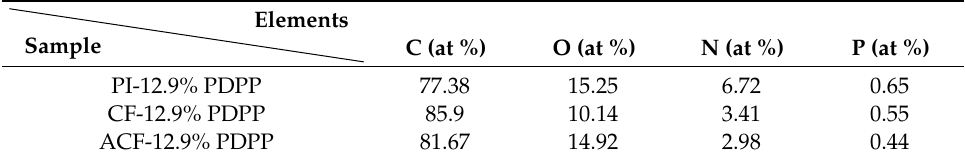
Table 3. Element content of fibrous networks prepared from PAA-12.9% PDPP through di ff erent thermal treatments.